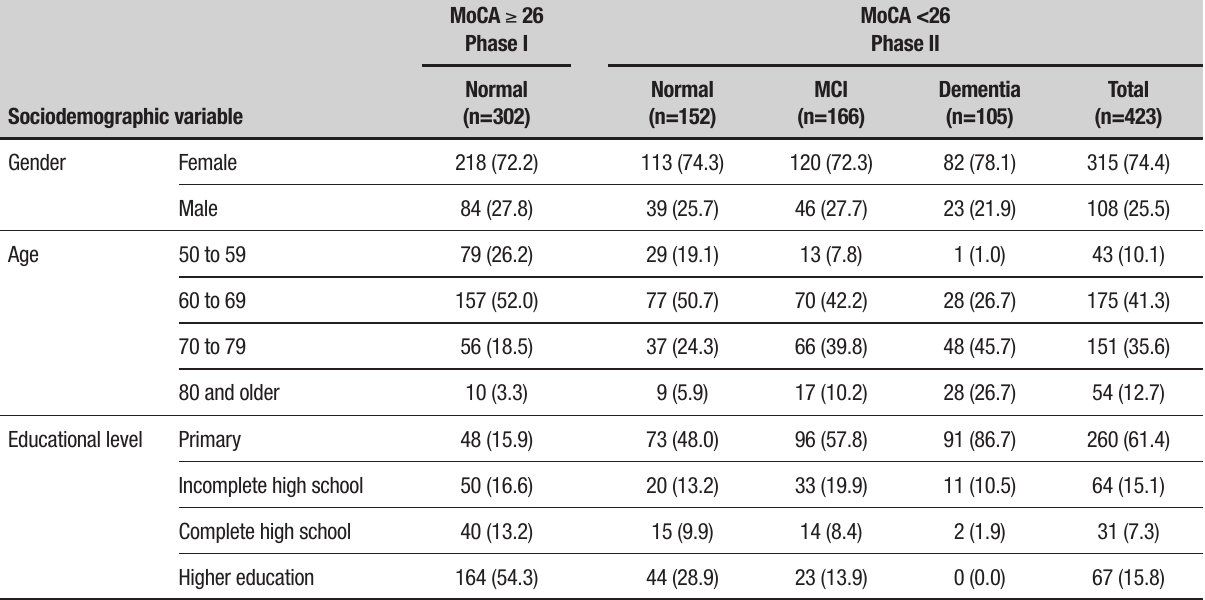
Table 1. Sociodemographic data of subjects with normal MoCA ( ≥ 26) in Phase I, and of subjects attending Phase II (MoCA<26), with cognitive diagnosis established by